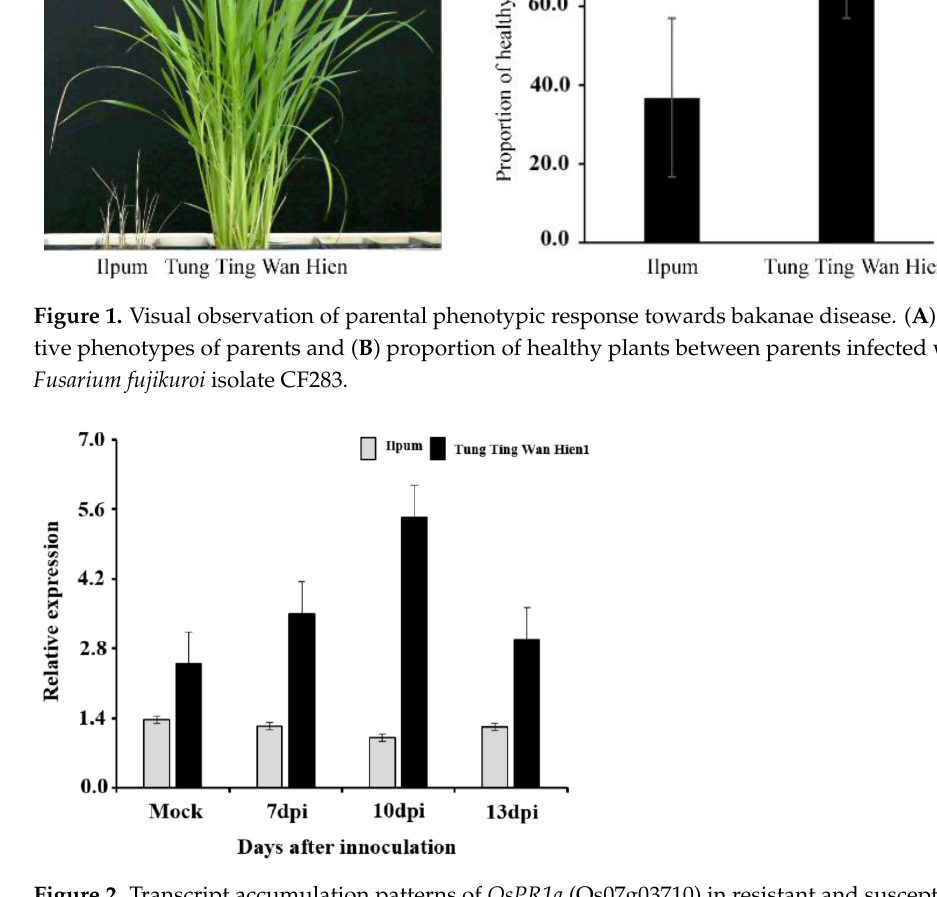
Figure 1. Visual observation of parental phenotypic response towards bakanae disease. ( A ) Distinc- tive phenotypes of parents and ( B ) proportion of healthy plants between parents infected with the Fusarium fujikuroi isolate CF283.